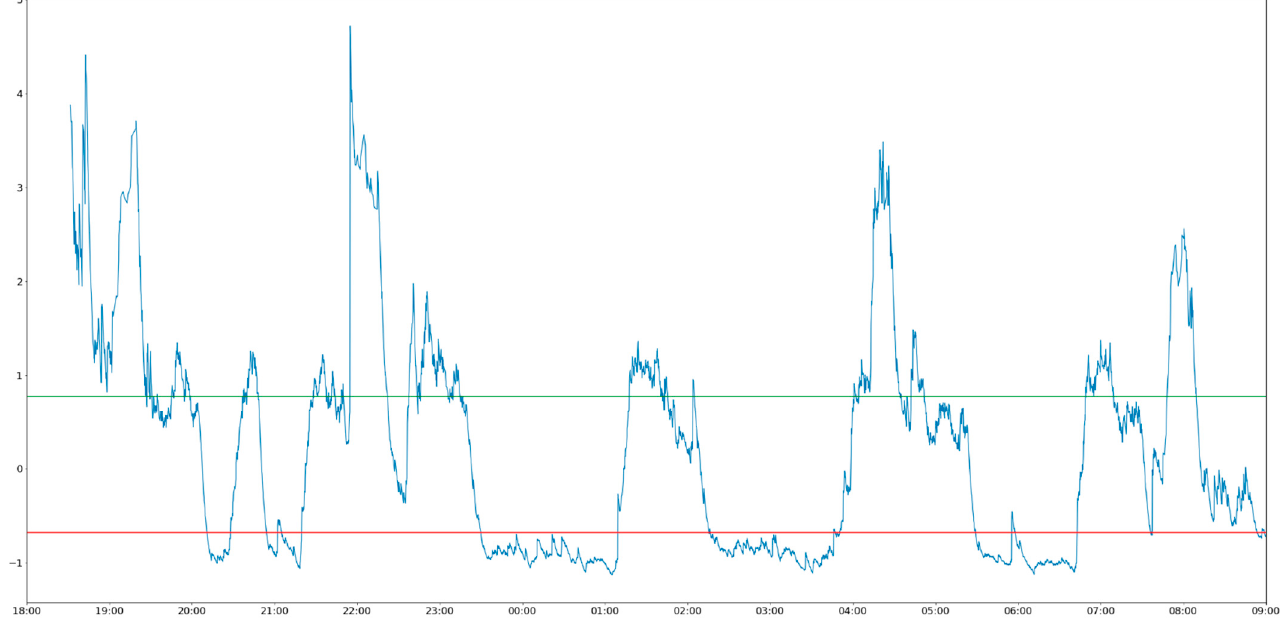
Figure 2. The DBA of the sheep wearing collar 2 was monitored by collar between 6:00 P.M. on 6 December and 9:00 a.m. on 7 December. The green and red lines represent the 0.8 and 0.4 percentiles respectively.